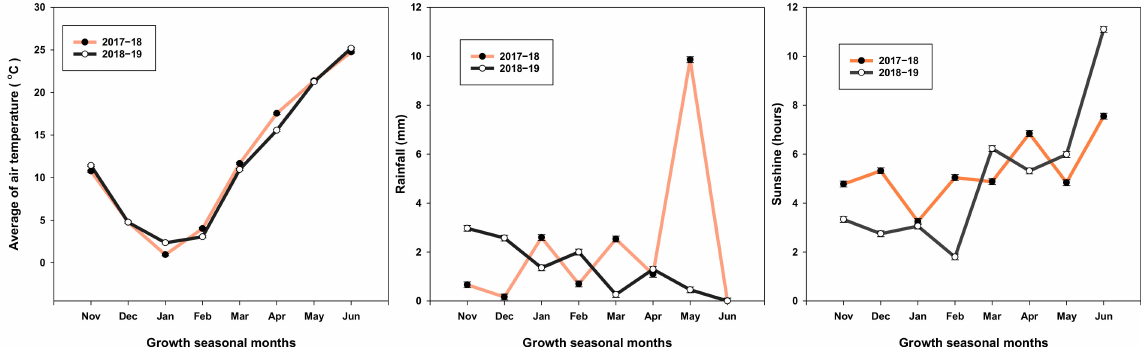
Figure 7. Metrological data: (monthly average temperature, rainfall (mm), and sunshine per hour) in two successive growing